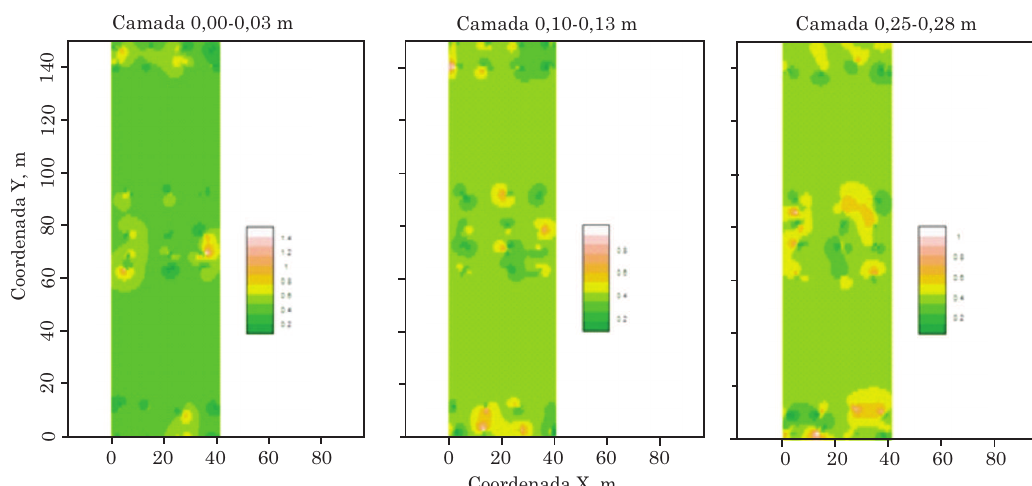
Figura 6. Mapa da distribuição espacial da resistência do solo à penetração na área de